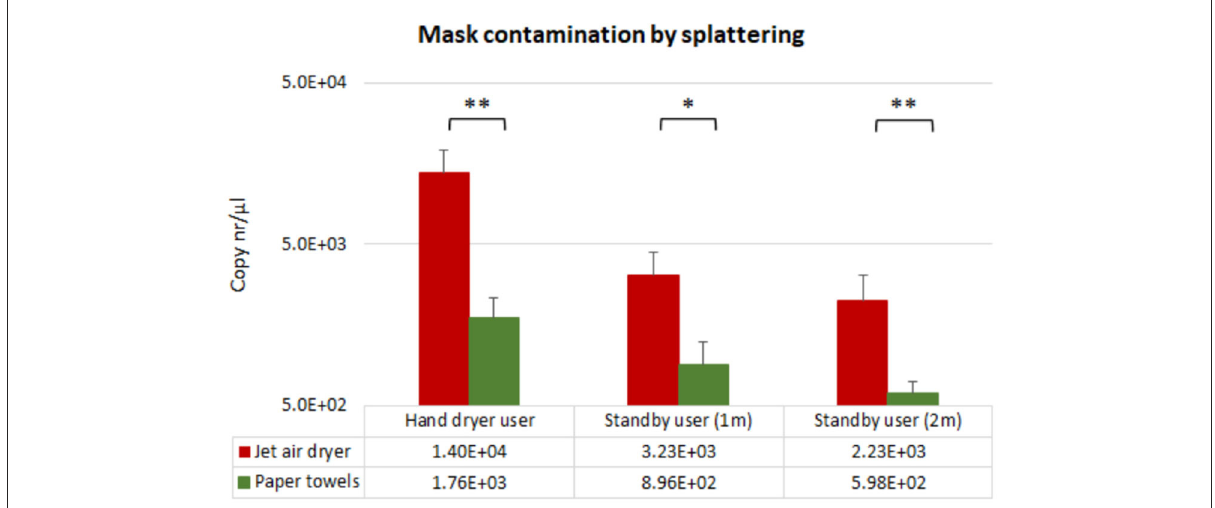
FIGURE2 Mean qPCR results for PR772 bacteriophage recovered from N95 masks immediately following hand drying (splattering). Bacteriophage recovery is presented as logarithms of gene copy numbers to achieve normal distribution. Concentration of PR772 bacteriophage in the hand immersion solution was 6.5 x 10 8 copies/ µ l. Single asterisk and double asterisk correspond to * p < 0.1 and ** p < 0.05 significant difference between hand drying methods using the Mann-Whitney test,